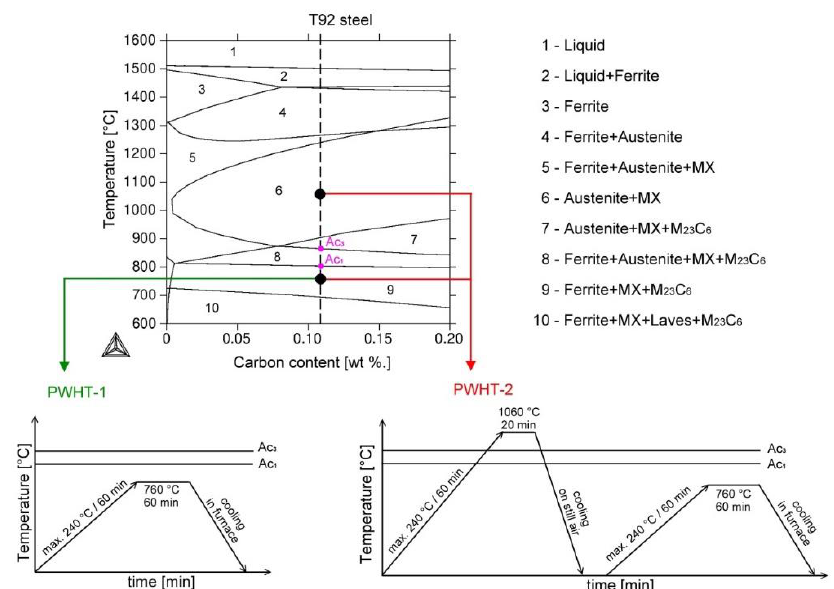
Figure 1. Calculated equilibrium phase diagram with schematic illustrations of individual post-welding heat treatment (PWHT) regimes applied in the present study for T92/T92 weldments (The T92 steel composition is indicated in the diagram by vertical dashed line at 0.11 wt.% C).